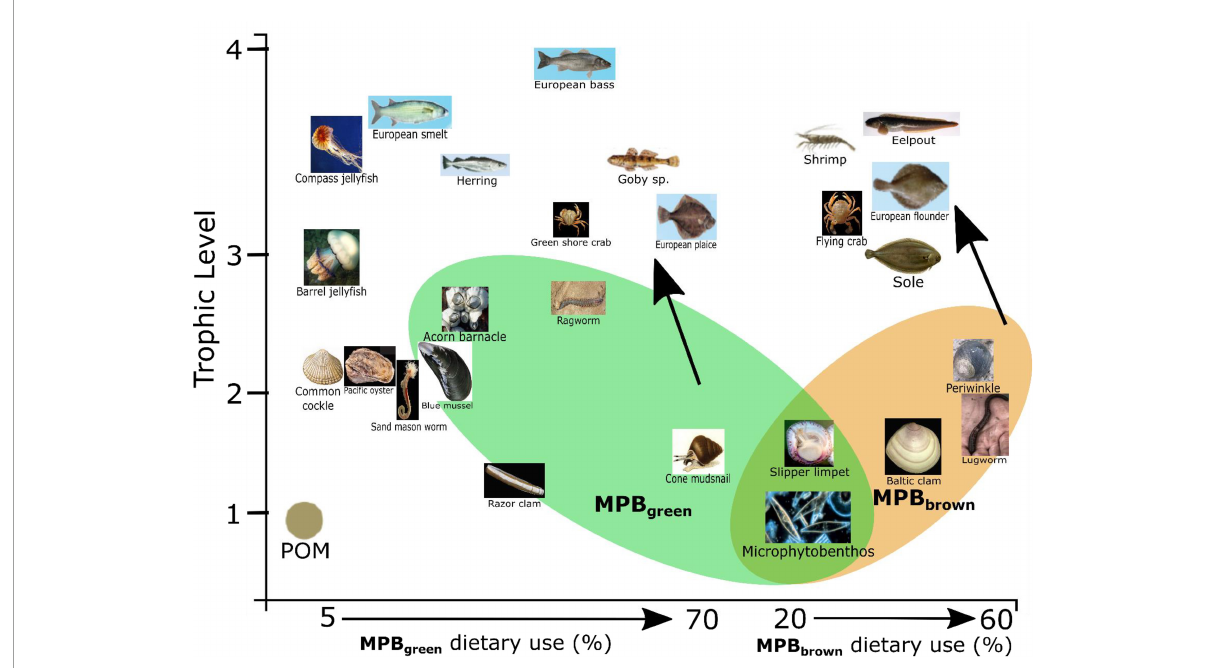
FIGURE6 Conceptual diagram indicating increased use of microphytobenthos-derived matter from either reworked material (MPB Brown ) or newly produced material (MPB green ) as use of particulate organic matter (POM) decreases. Photograph credits: Henk Heesen, Ales Kladnik, Francesca Crippa, Hans Hillewaert, Matthisas Buschmann, Sytske Dijksen, and Gordon